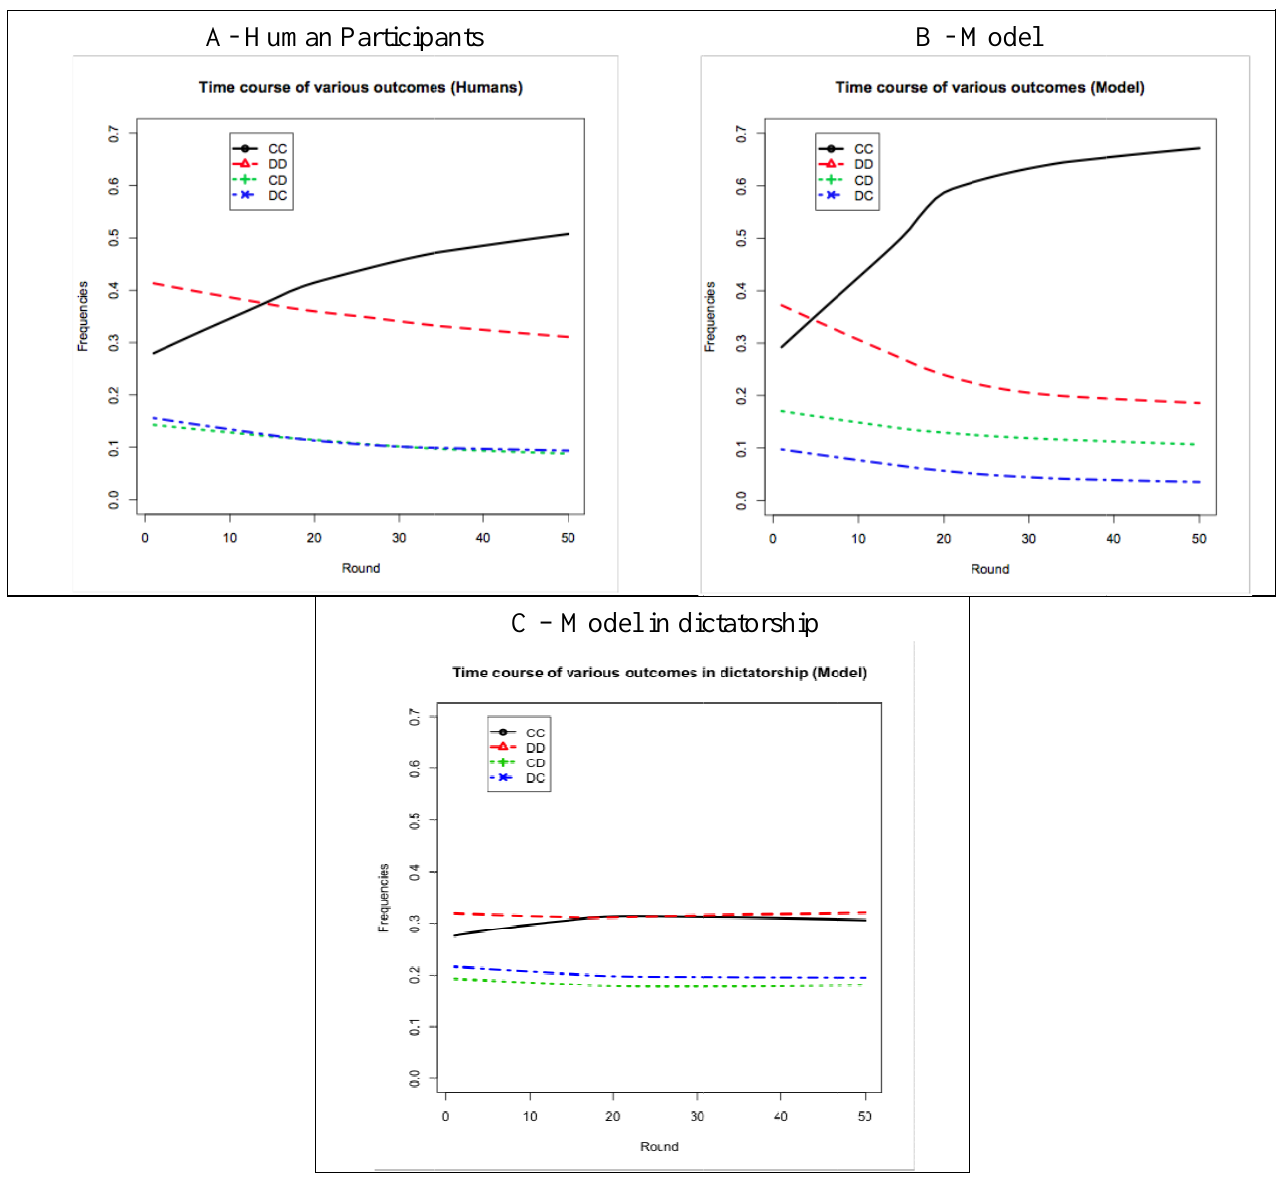
Figure e 6. Time Prison ner’s Dilem in dict tatorship.